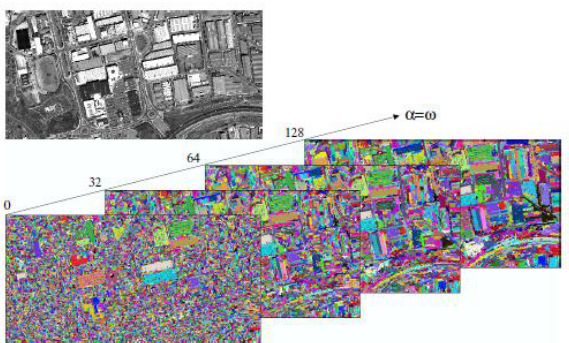
Figure 1. Example of constrained connectivity partitioning of a 512x256 sample of a WorldView-1